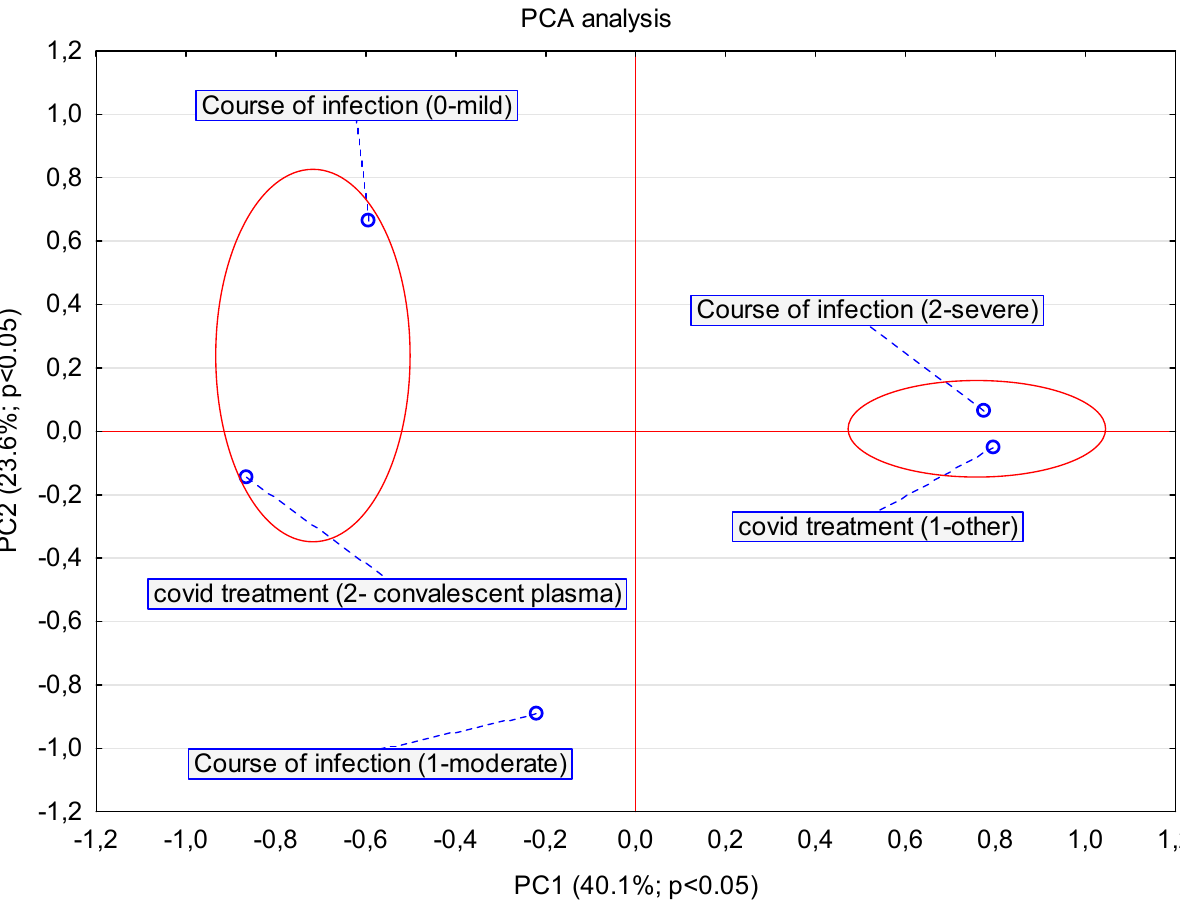
Figure 2. The PCA analysis presented in the pca1 vs. pca2 load diagram. Analysis of the effect of applied early plasma therapy on the course of COVID-19 in hematological patients using generalized principal component analysis PCA. The PCA model was estimated using the NIPALS iterative algorithm, the convergence criterion was set at the level of 0.00001, setting the maximum number of iterations at 50. The number of components was determined by determining the maximum predictive capability Q^2 using the V-fold cross-validation method, setting the maximum number of components at the level of V_max = 7. The obtained optimal PCA model was finally reduced to 2 components.